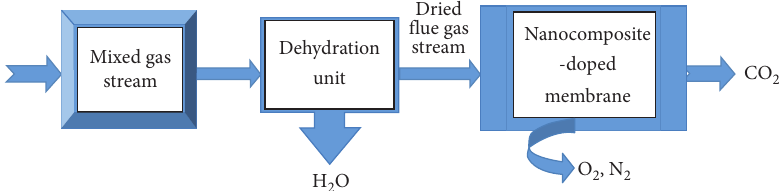
Figure 5: Flow diagram for proposed nanocomposite-doped membrane separation